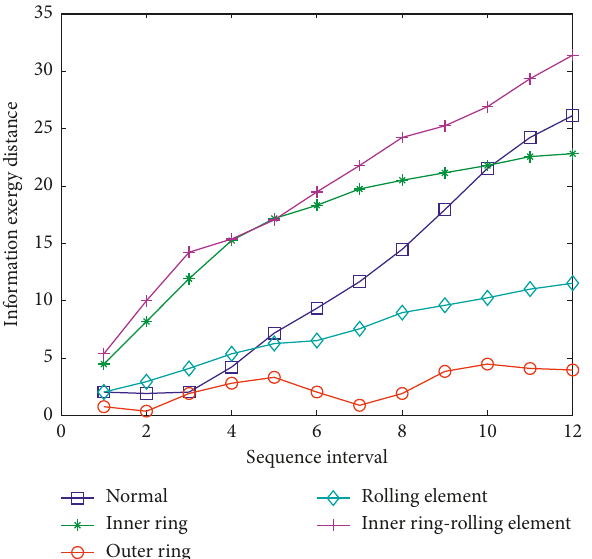
Figure 8: Information exergy distance of the inner ring-rolling element coupling